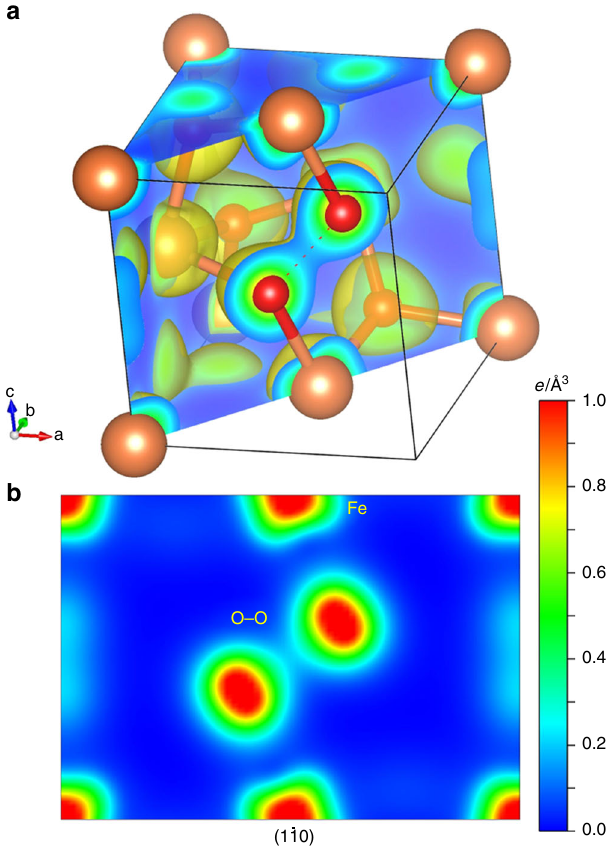
Fig. 4 The calculated charge density landscape of pyrite-structured FeO 2 at 100 GPa. a Gold surface represents charge density of 0.15 e /Å 3 . The section cut through the ð 1 (cid:1) 10 Þ plane shows the weak O – O bonding feature. Brown balls are Fe atoms and red balls are O atoms. b Charge density distribution projected on the ð 1 (cid:1) 10 Þ plane. The level of charge density is re fl ected by the color